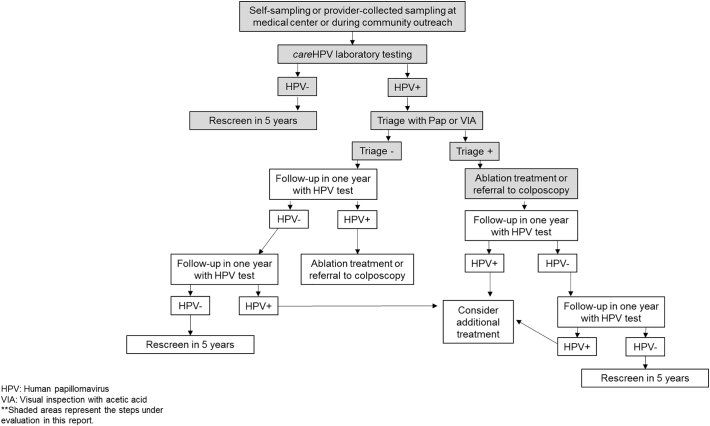
General algorithm for the screening intervention using HPV as primary screening test under the Scale-project in Guatemala, Honduras and Nicaragua.